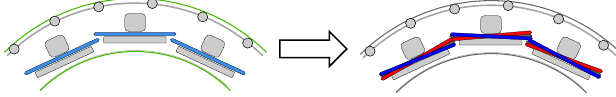
Figure 4. Illustration of the impact of misalignment on the sensitive elements of a tracking detector. On the left, the blue sensors are aligned nominally, while on the right the impact of di ff ering alignment per IOV is illustrated by the variation of blue and red sensor